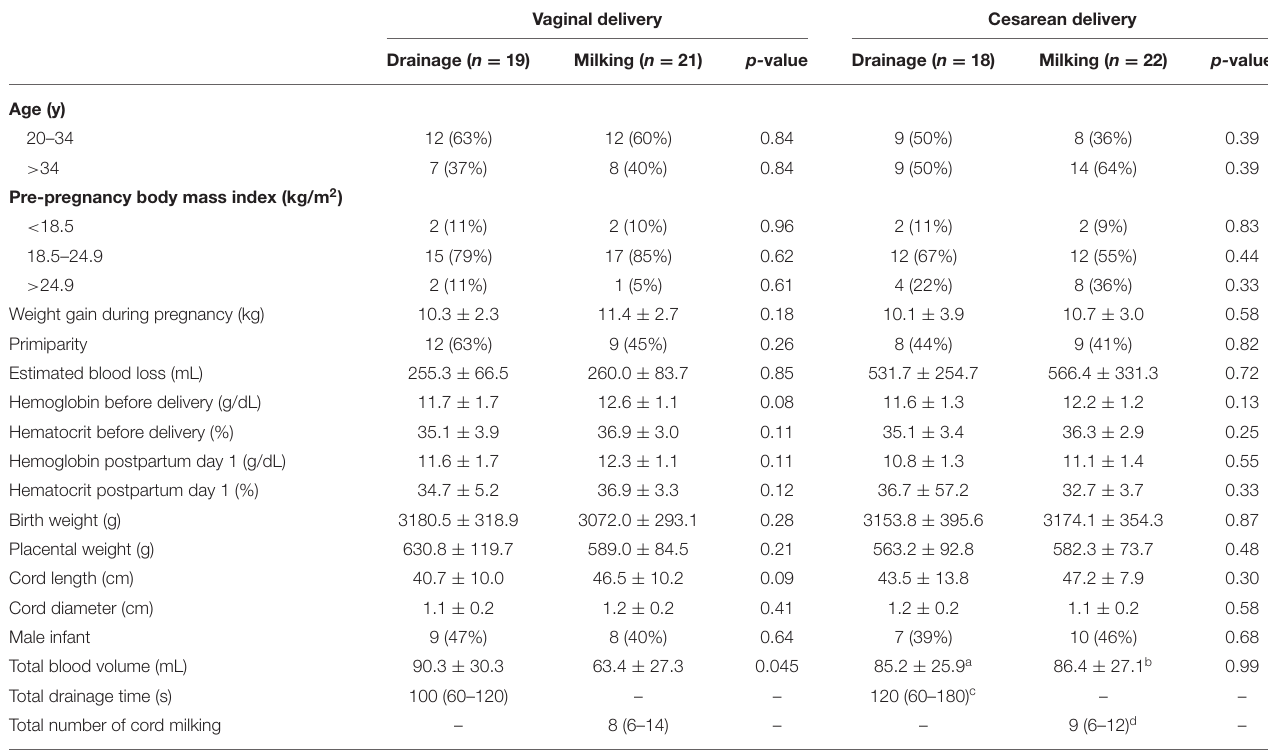
TABLE 1 | Maternal characteristics and neonatal